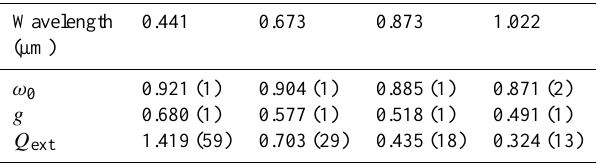
Table 2. Aerosol optical properties (single scattering albedo ( ω 0 ) , asymmetry parameter ( g ) and extinction efficiency factor ( Q ext )) obtained from AERONET Lev. 2.0 aerosol inversion product used in the radiative transfer code SBDART. The numbers in parentheses represent the uncertainty in the last decimal